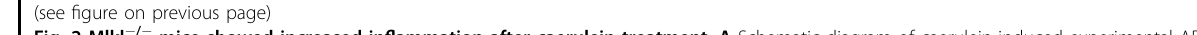
Fig. 2 Mlkl − / − mice showed increased in fl ammation after caerulein treatment. A Schematic diagram of caerulein-induced experimental AP in vivo. Mlkl + / − and Mlkl − / − mice were intraperitoneally injected with either 100 µg/kg caerulein or saline every hour for eight consecutive hours. The mice were sacri fi ced at 2, 4, 8, and 24 h after the fi rst injection. The total weight gain ( B ), pancreatic weight ( C ), and the ratio of pancreatic weight to fi nal body weight ( D ) were determined. E Pancreatic edema formation was determined by the wet/dry weight ratio in mice sacri fi ced at 3 h after the last injection. The results are representative of three independent experiments with a minimum of fi ve mice per group. F The cell number in each group was determined by an automated cell counter. G , H Representative H&E images of the pancreas and histological scores of pancreatic edema, necrosis, and in fl ammation were evaluated in mice sacri fi ced 8 and 24 h after the fi rst injection; saline or 100 µg/kg caerulein was injected every hour for eight consecutive hours ( n = 6 − 15 in each group). The data are presented as the means ± SEMs. * P < 0.05, ** P < 0.01, and *** P < 0.001. These data are representative of three